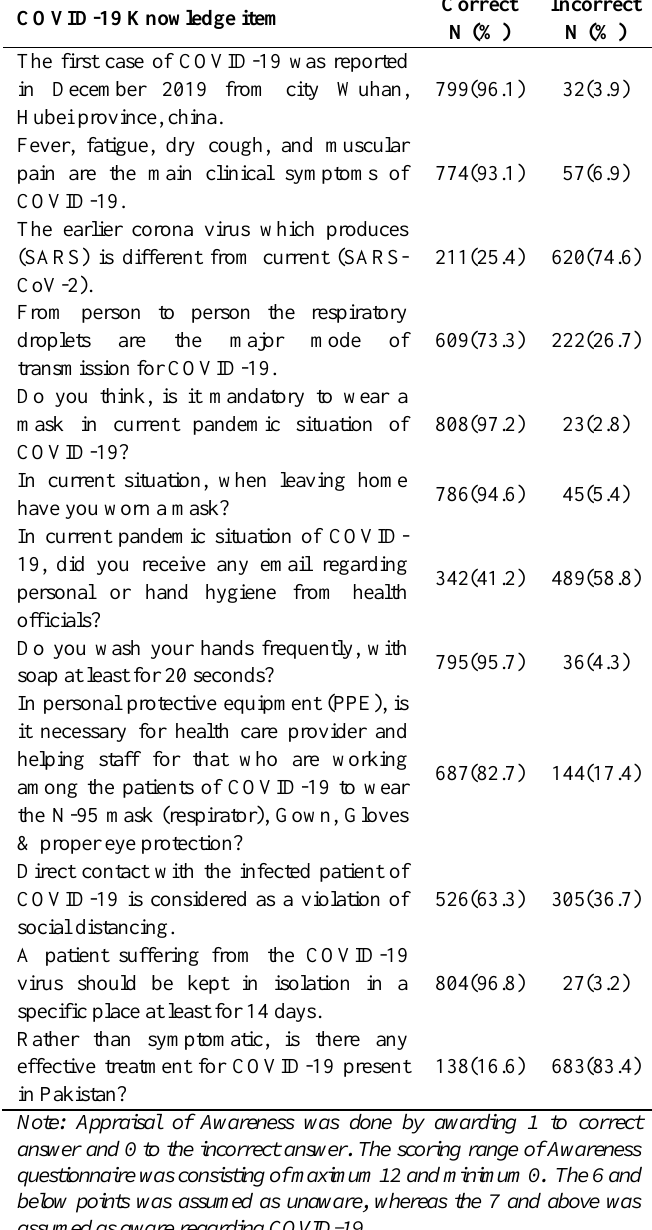
Table 2: Response to COVID-19 Awareness items .